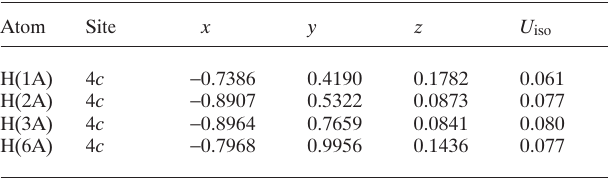
Table 2. Atomic coordinates and displacement parameters (in Å 2 )